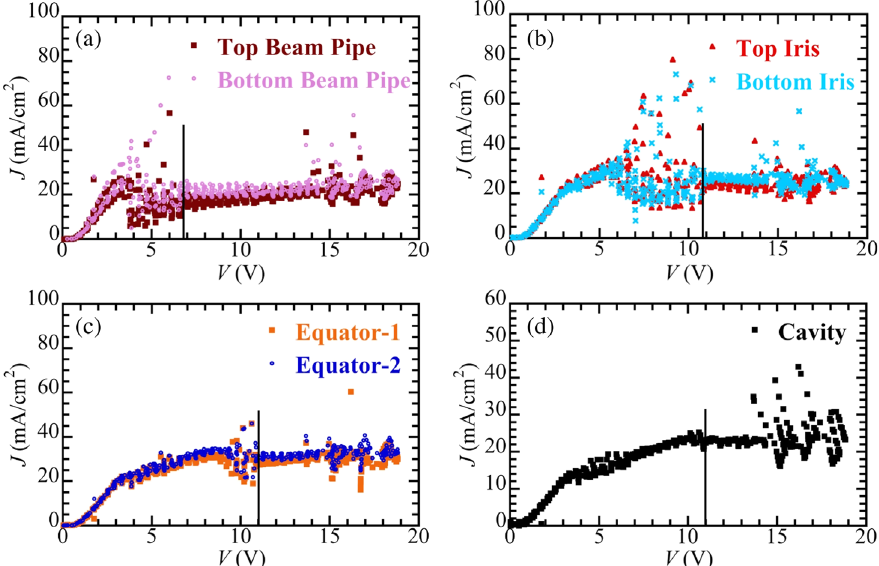
FIG. 4. J (cid:1) V curves for the coupons (a) – (c) and cavity (d) in the VEP process performed with cathode rotation at 20 rpm, a cavity temperature of 17 °C, and an acid flow rate of 5 – 10 L = min. The vertical solid line in each plot represents the start of the EP plateau.